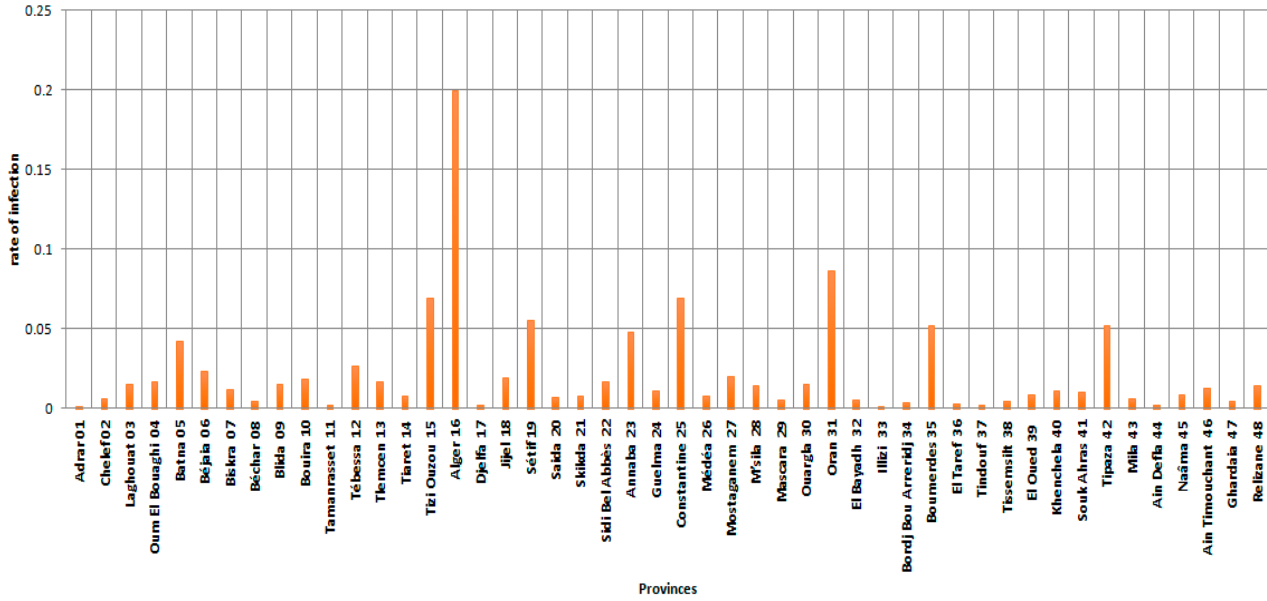
Figure 9. Infection rates in the provinces (48 provinces) by COVID-19 between 1 January 2021 and 15 August 2021.